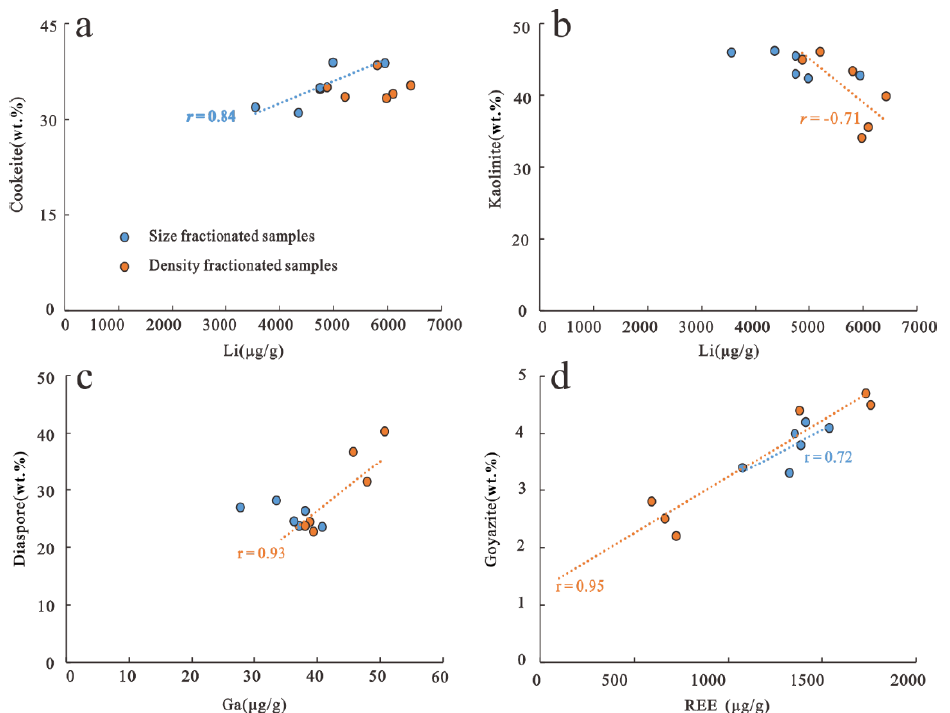
Figure 9. Relationship of Li vs. Cookeite ( a ), Li vs. Kaolinite ( b ), Ga vs. Diaspore ( c ), REE vs. Goyazite ( d ) in the low-grade bauxite samples subjected to size and density fractionation.